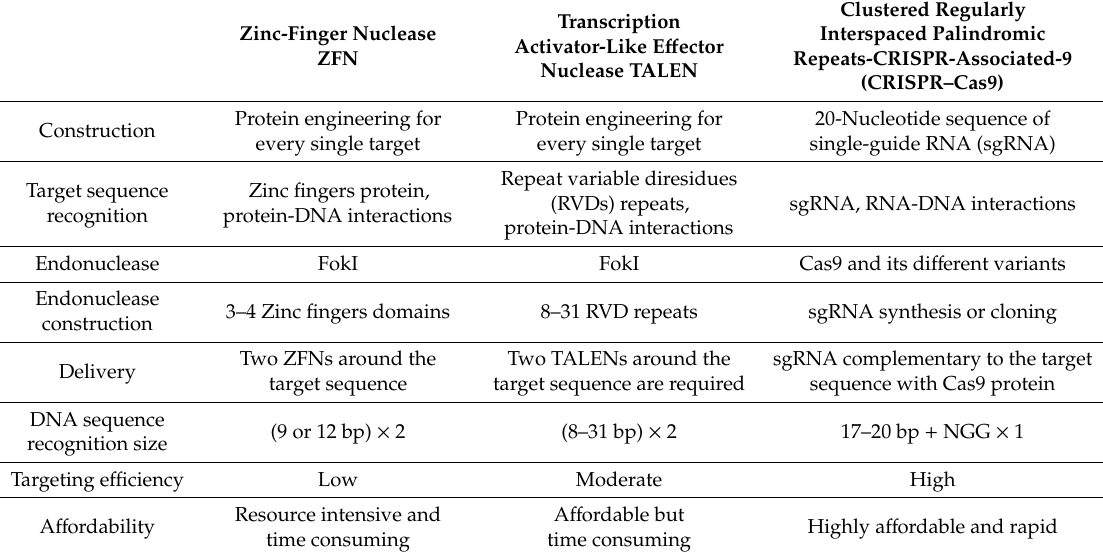
Table 2. Systematic comparison of the three genome editing tools: ZFN, TALEN, CRISPR–Cas9 [38–41]. Zinc-Finger Nuclease